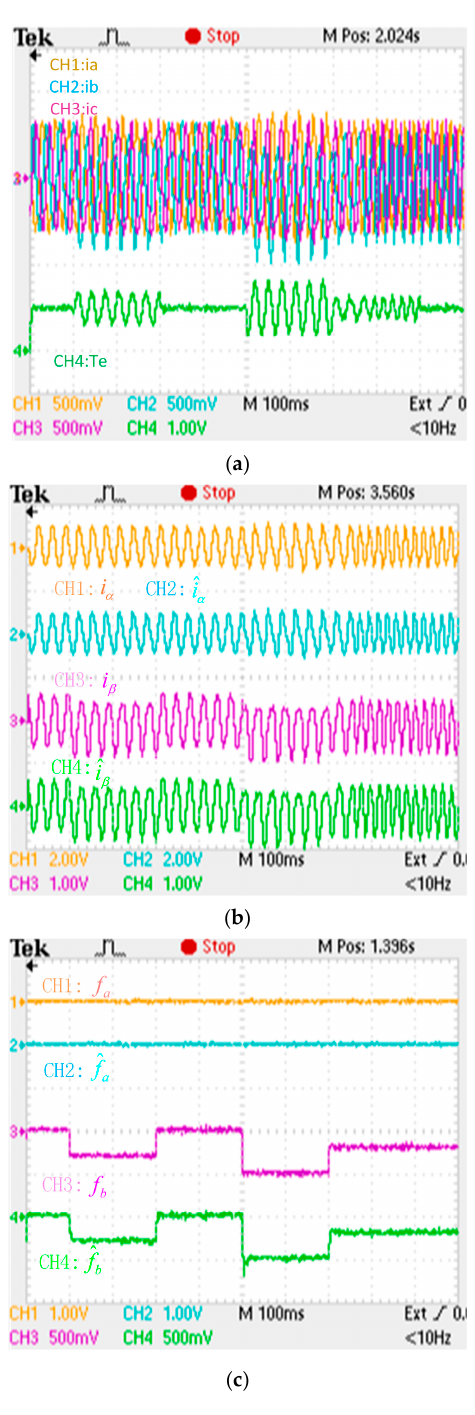
Figure 17. Experimental results when an intermittent fault is applied to the “b” phase current sensor. ( a ) phase currents and electromagnetic torque responses (iabc: 75 A/div; Te: 500 Nm/div; t : 100 ms/div); ( b ) actual and estimation αβ axis stator currents responses (i α : 200 A/div; i β : 150 A/div; t : 100 ms/div); ( c ) phase currents fault and its reconstruction (fa: 1 A/div; fb: 50 A/div; t : 100 ms/div).